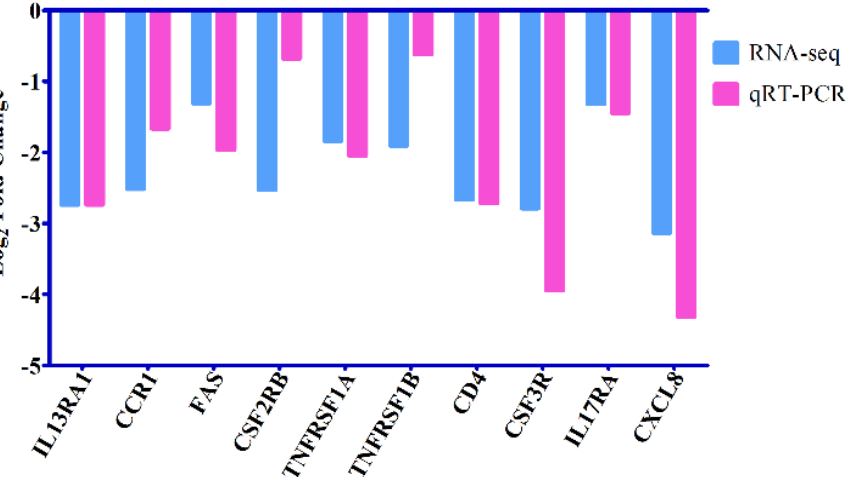
Figure 2. Verification of the expression of 10 selected differentially expressed mRNAs (DEmRNAs). The Y-axis denotes the log 2 fold change, and the X-axis shows the analyzed DEmRNAs.